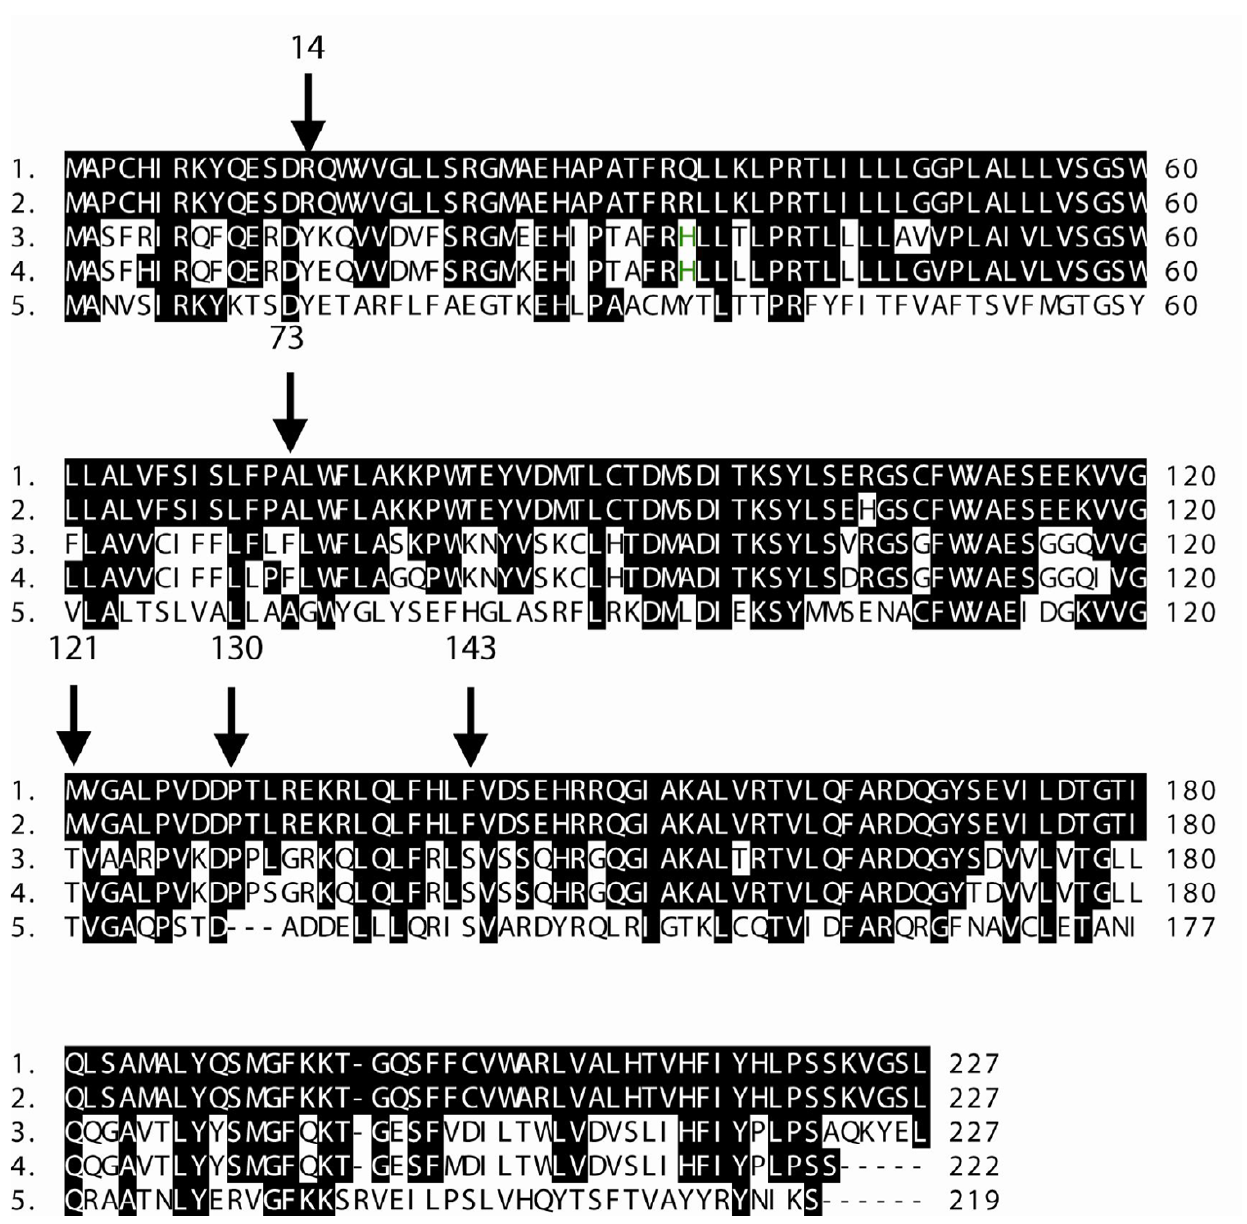
The alignment of NAT8 protein sequences: 1- Homo sapiens , 2- Pan troglodytes , 3- Mus musculus , 4- Rattus nor- vegicus , 5- Xenopus tropicalis . Arrows pointing at polymorphic amino acid positions (14 Arg-His, 73 Ala-Val, 121 Met-Thr, 130 Pro-Pro, 143